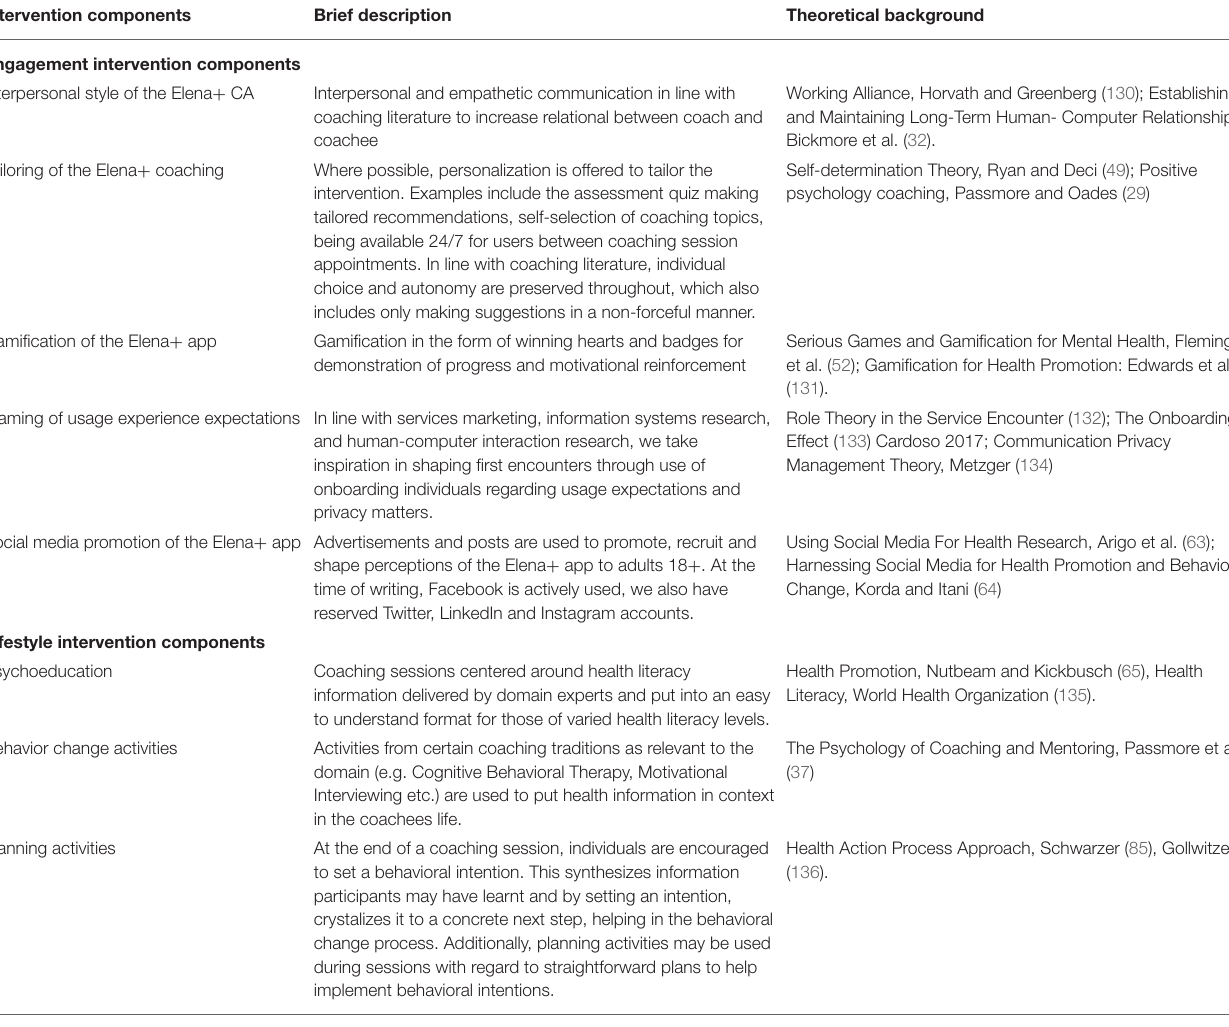
TABLE 2 | Intervention components.